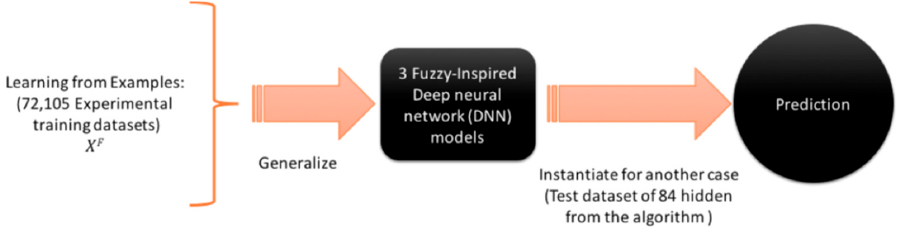
Figure 6. How the deep neural network algorithms were trained on the training dataset and objectively evaluated using the testing dataset that was hidden from the algorithm during training.